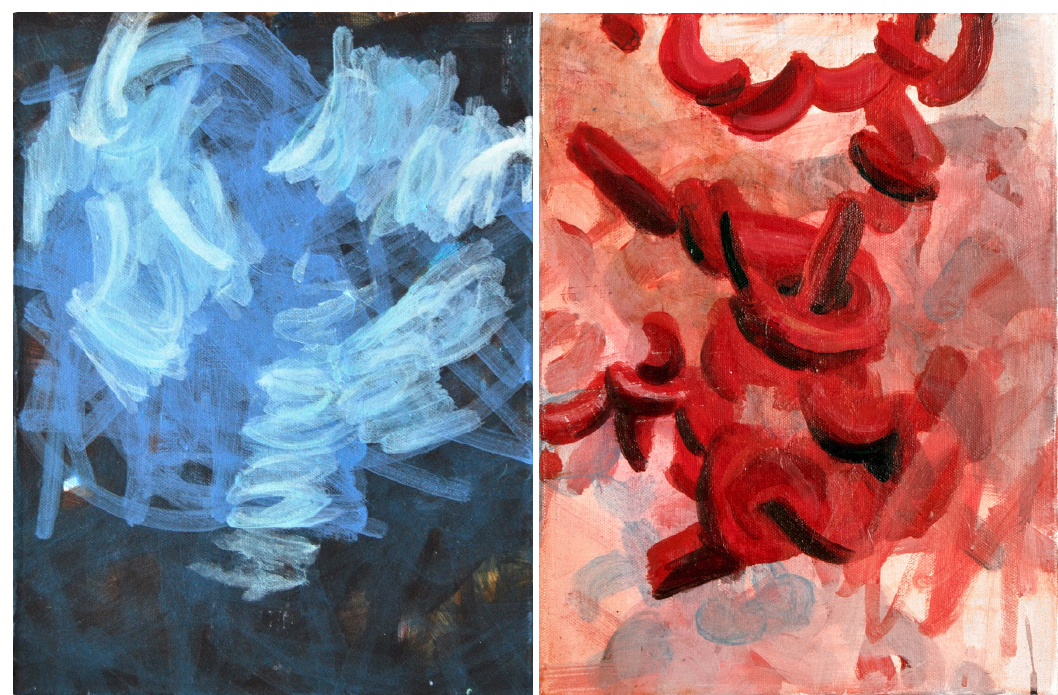
Figure A2. “Resisting Gravity in Blue and Red”, Acrylic on canvas, 30 cm × 40 cm. 2016, c (cid:13) Liat Grayver.